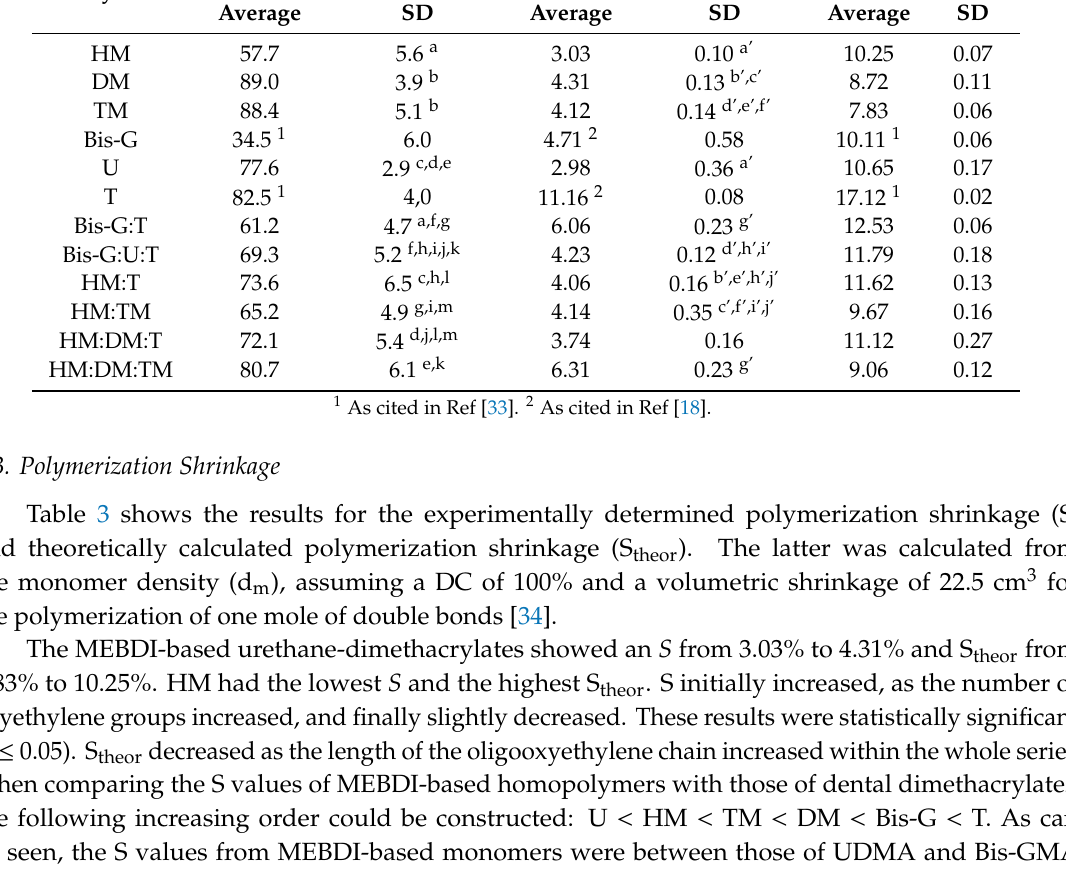
Figure 1. The representative FTIR spectra of the DM: ( a ) monomer and ( b ) polymer. Table 3. The degree of conversion (DC) and polymerization shrinkages, experimentally measured (S) and theoretically calculated (S theo r ) in the studied polymers. The majority of the results were statistically significant ( p ≤ 0.05). Couples, that revealed statistically insignificant results ( p > 0.05) were highlighted with letters: a–m – for the DC and a’–j’ – for the S.